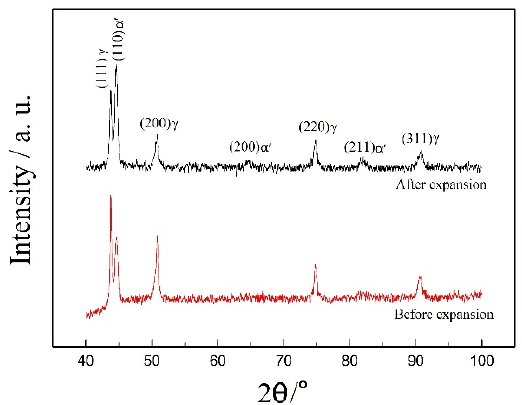
Figure 2. XRD patterns for AISI 304 SS tube before and after expansion.